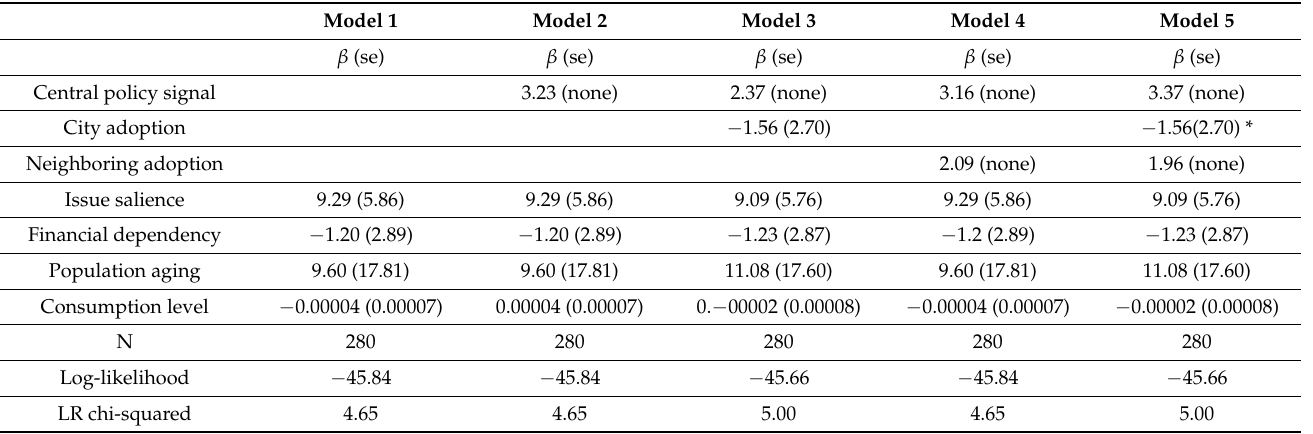
Table A1. Event history analysis (EHA) models for EMDER policy adoption by provincial govern- ments in